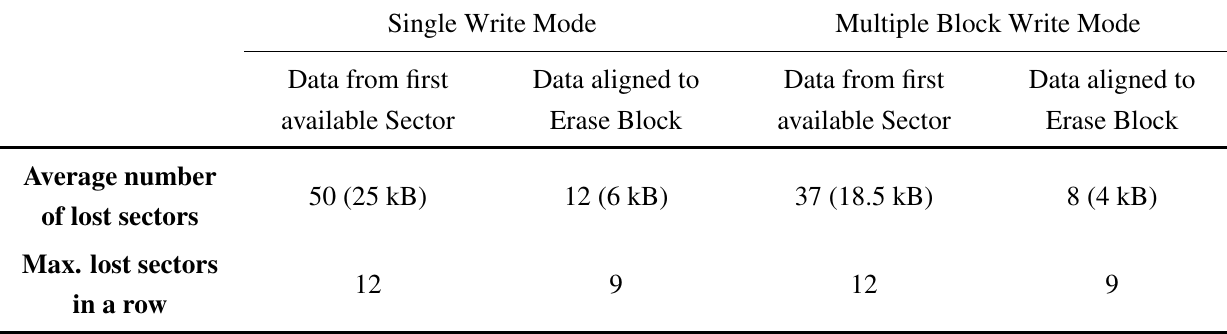
Table 3. Data loss test.